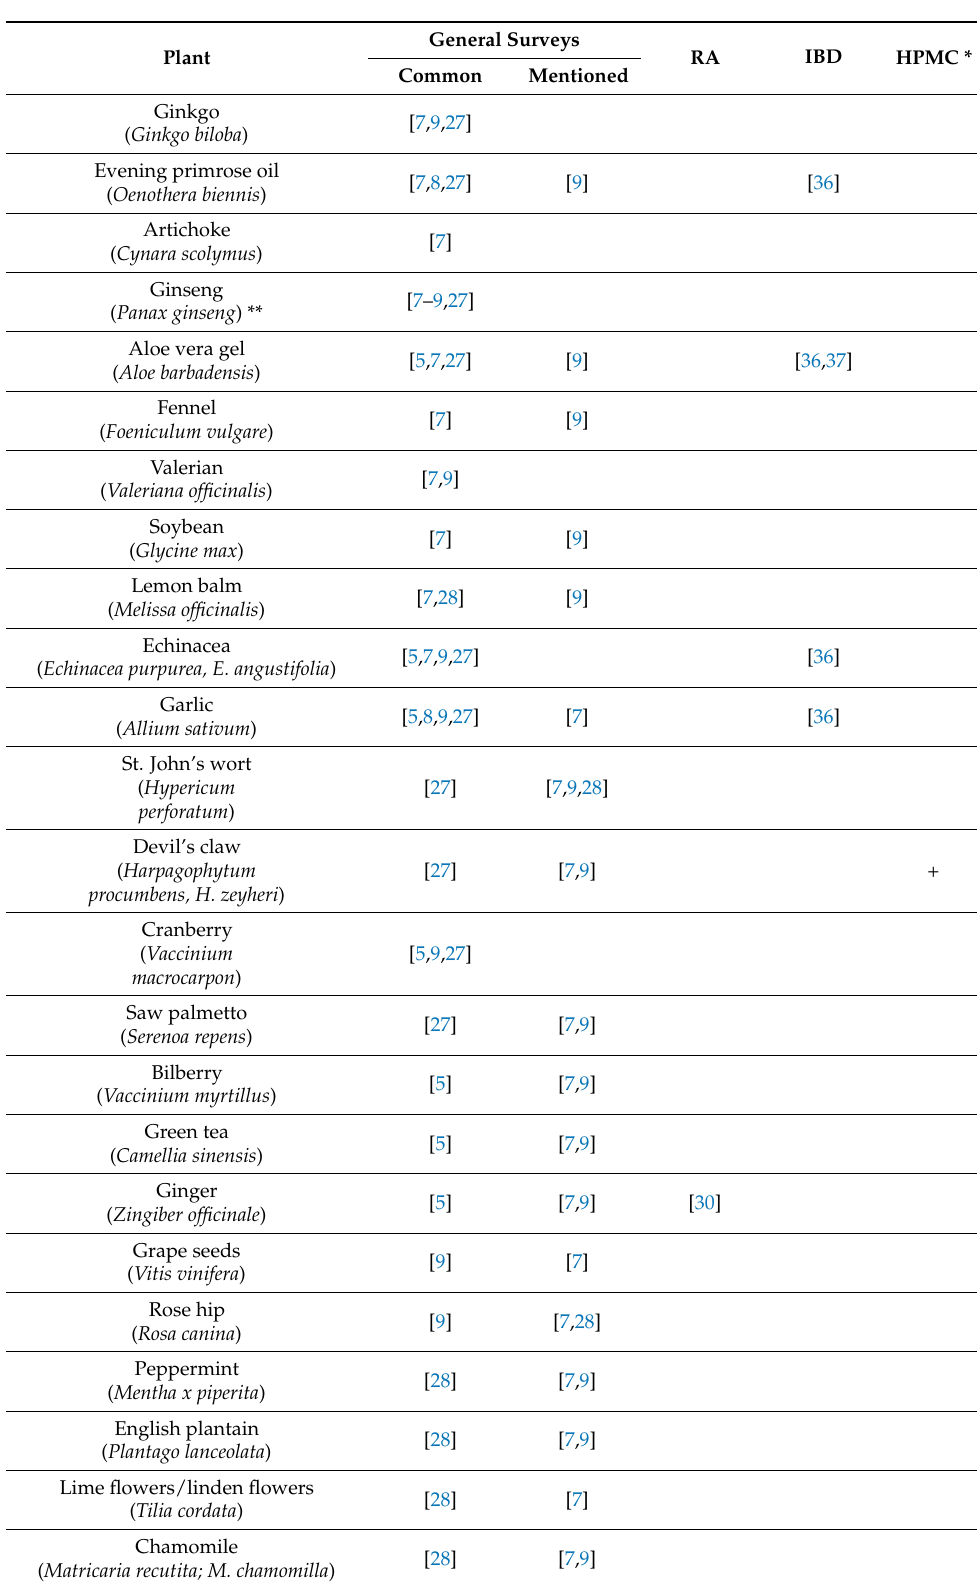
Table 1. This table lists the plants considered for possible interactions, with both their English and botanical names. It indicates if they were reported in general surveys or by patients with rheumatoid arthritis/inflammatory bowel disease, if they could be considered useful for treatment of these conditions, and the